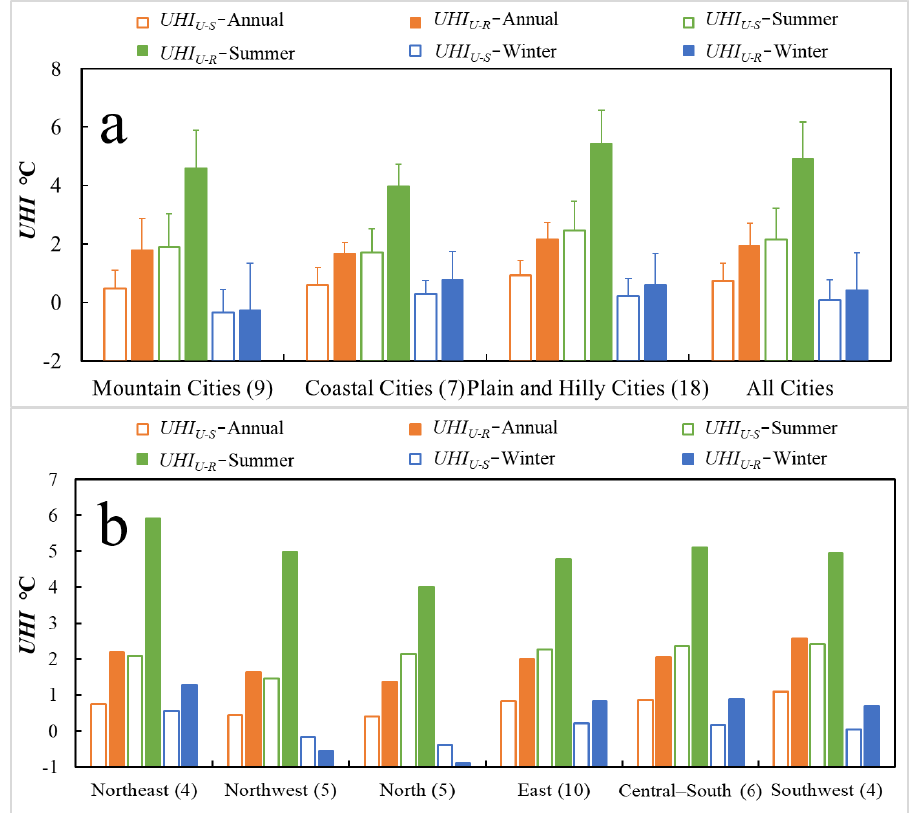
Figure 6. Average values of UHI U − S and UHI U − R for ( a ) different topographies and ( b ) regions. Numbers in parentheses on the x-axes are the numbers of cities.